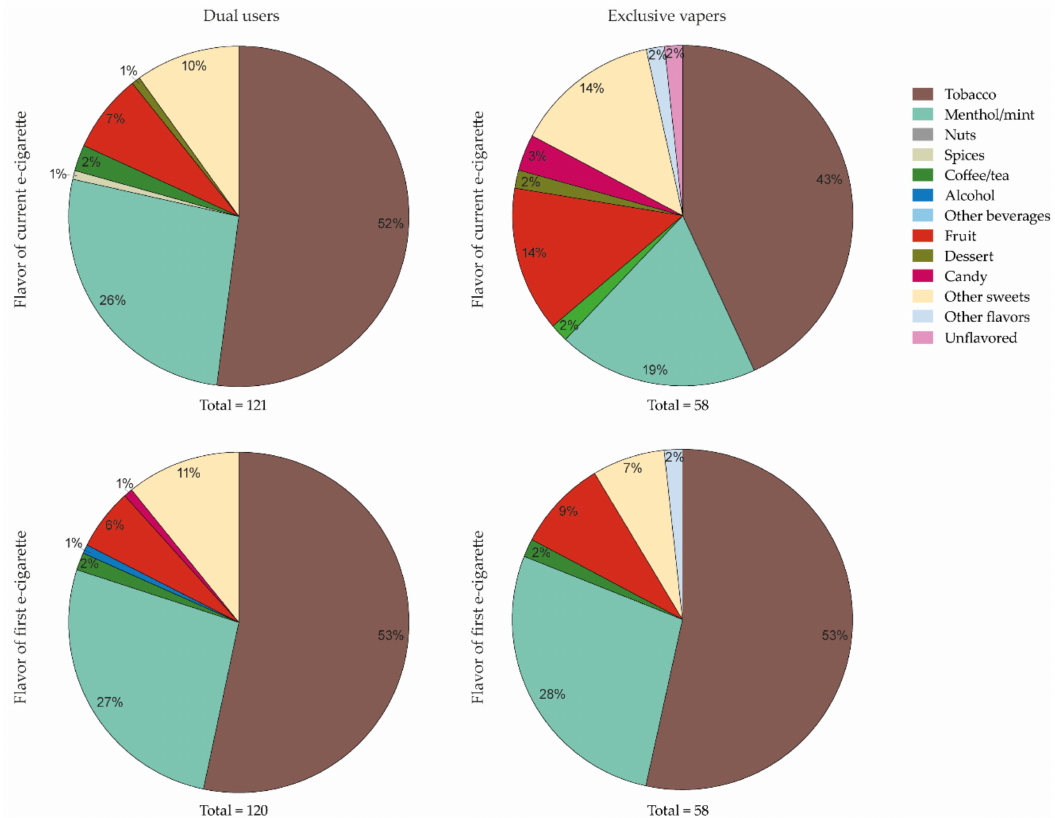
Figure 2. Flavors used on current (top) and first (bottom) e-cigarette exposure among dual (left) and exclusive vapers (right). Participants could select only one flavor category to indicate the flavor of their current and first e-cigarette used. Data are presented as percentages of the total number of responses, not of the total sample